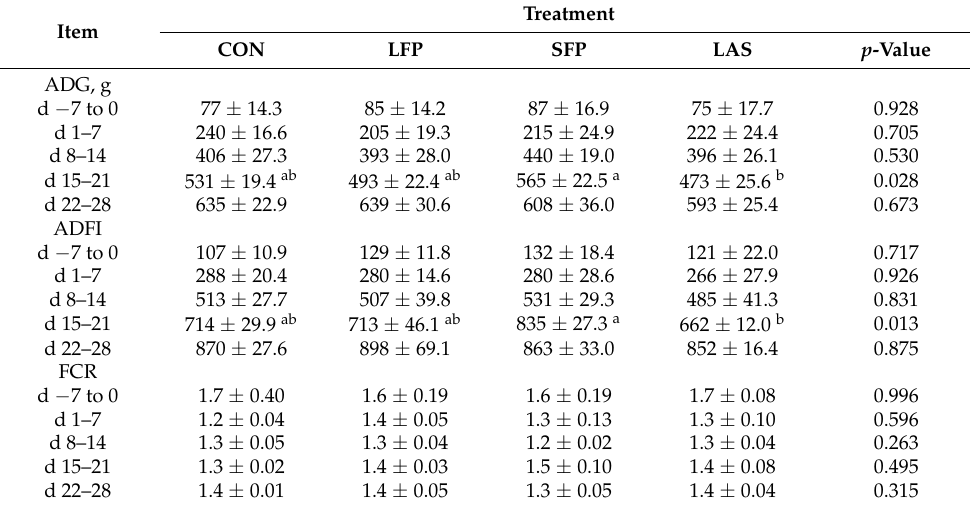
Table 2. Effects of postbiotics on average daily gain (ADG), average daily feed intake (ADFI) and the feed conversion ratio (FCR) in ESC-resistant E. coli -challenged weaner